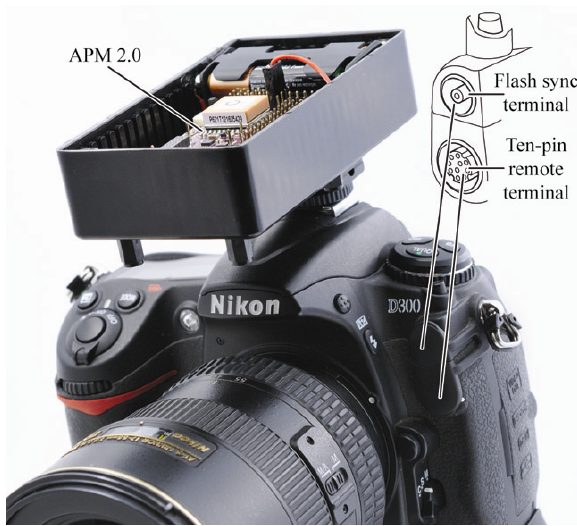
Figure 2. APM 2.0 mounted on top of a Nikon D300